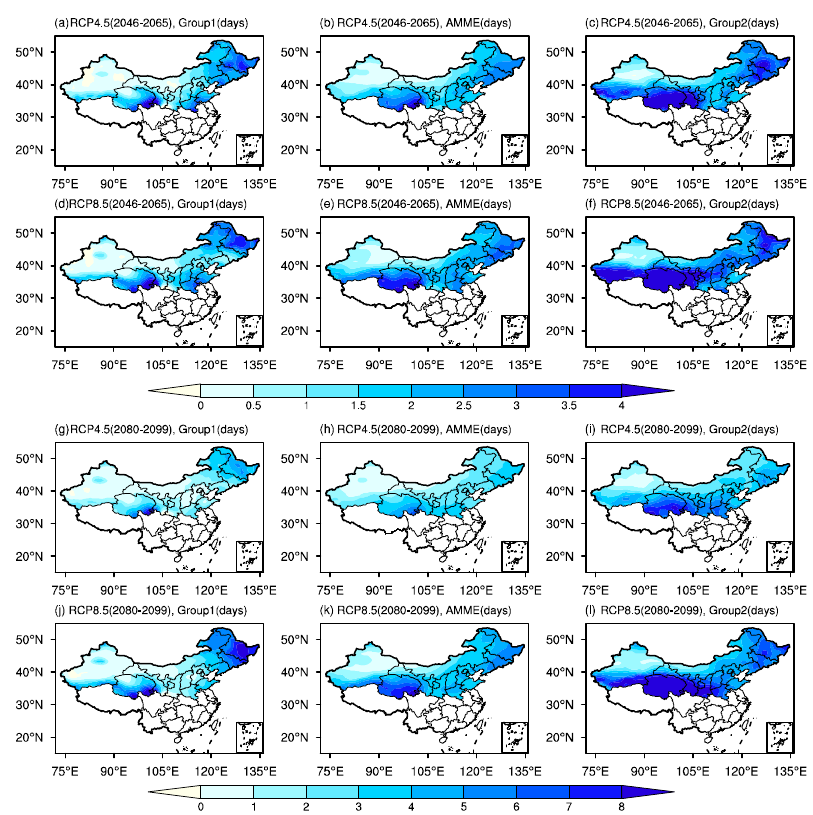
Figure 10. Same as in Figure 9 but for RX5d.